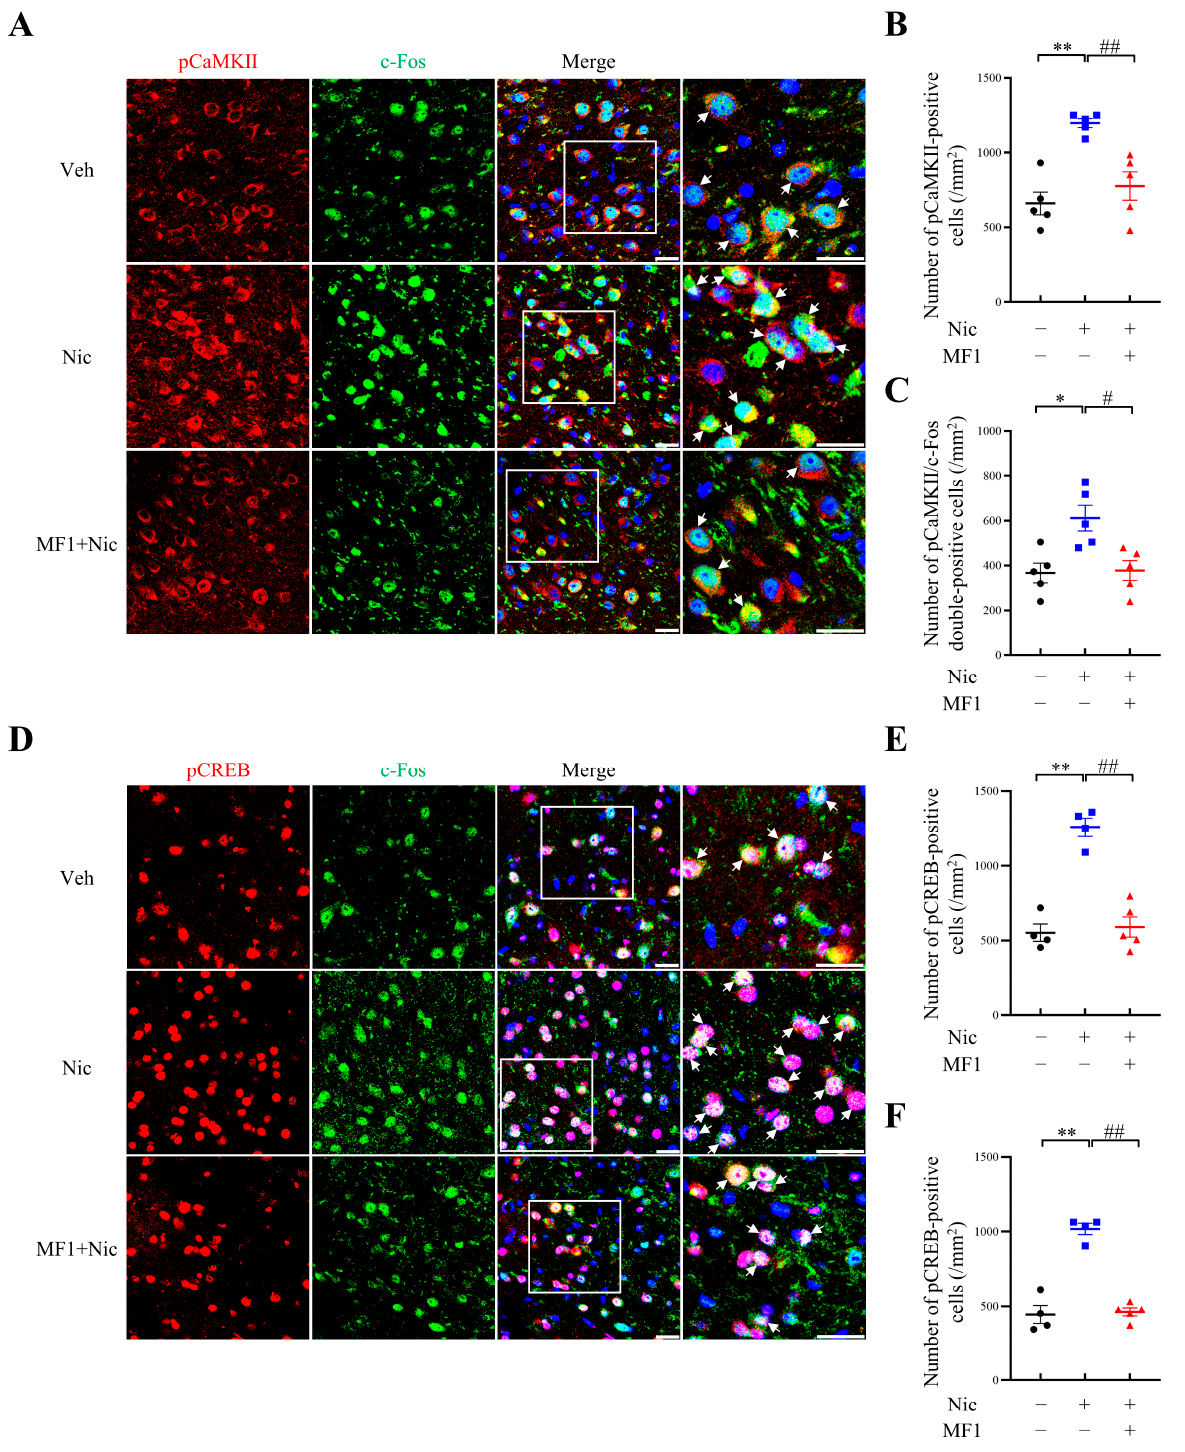
Figure 3. Numbers of phosphorylated CaMKII- and CREB-positive cells, and c-Fos expression in the NAc following CPP tasks. ( A – C ) Representative confocal images and quantitative data for autophosphorylated CaMKII-positive cells and autophosphorylated CaMKII/c-Fos double-positive cells in mouse NAc. Chronic nicotine administration significantly increased the numbers of autophosphorylated CaMKII-positive cells (red) and autophosphorylated CaMKII/c-Fos double-positive cells (green) in the CPP tasks, whereas these increases were restored by MF1 pretreatment ( n = 5 per group). DAPI-stained nuclei are shown in blue. * p < 0.05 vs. vehicle-treated group; ** p < 0.01 vs. vehicle-treated group; # p < 0.05 vs. nicotine-treated group; ## p < 0.01 vs. nicotine-treated group. ( D – F ) Representative confocal images and quantitative data for phosphorylated CREB- positive cells (red) and phosphorylated CREB/c-Fos double-positive cells (green) in mouse NAc.